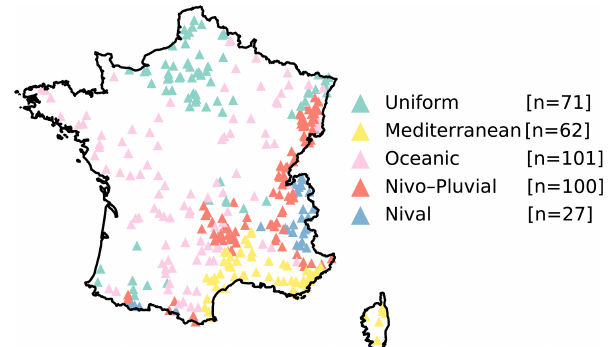
Figure 3. Distribution of catchments from each of the five regimes across France: Uniform, Mediterranean, Oceanic, Nivo–Pluvial, and Nival. Each point represents one catchment and is coloured ac- cording to its